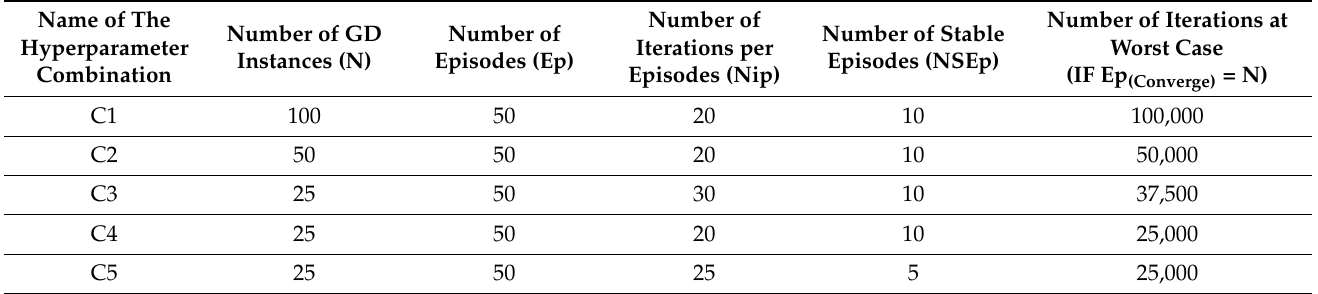
Table 3. Various hyperparameter combinations of